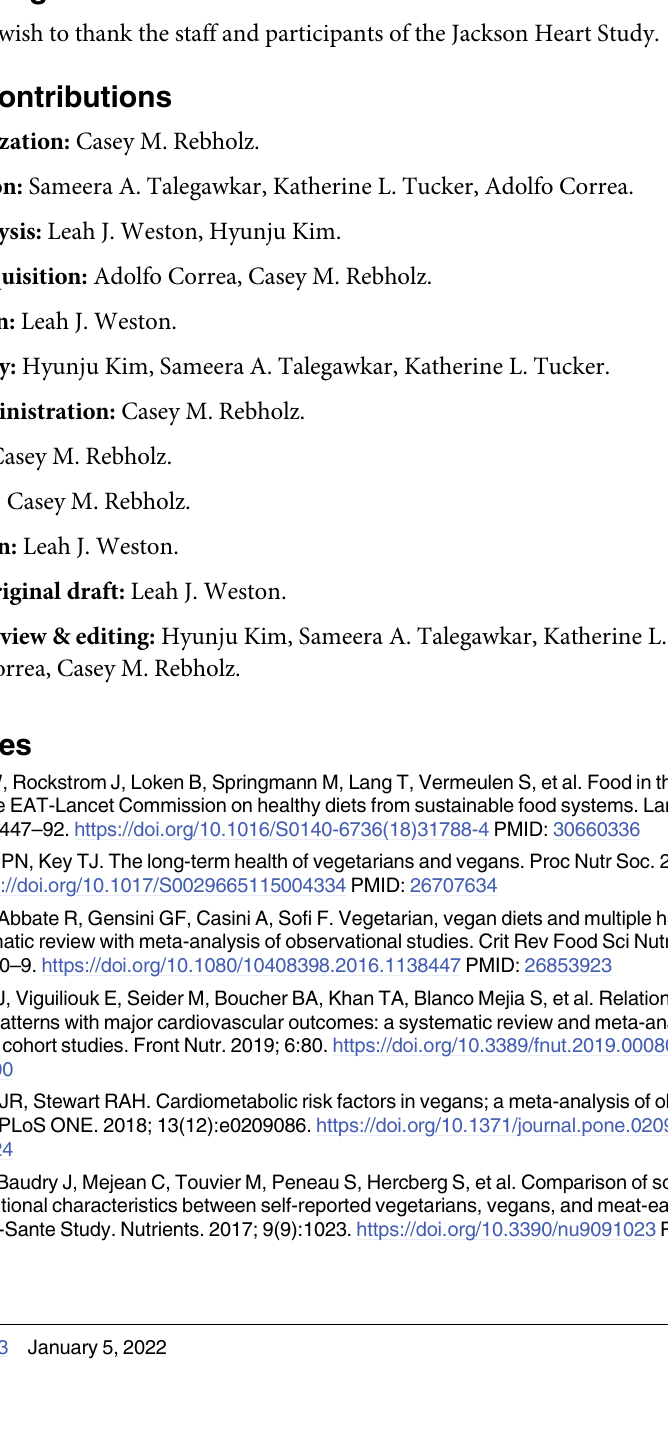
S11 Table. Hazard ratios (95% confidence intervals) for incident cardiovascular disease (CVD) and all-cause mortality and plant-based diet indices for progressively adjusted models using quintiles (instead of tertiles). S12 Table. Adjusted hazard ratios � and 95% confidence intervals for incident cardiovascu- lar disease and all-cause mortality for highest versus lowest quintile of score components of the plant-based diet